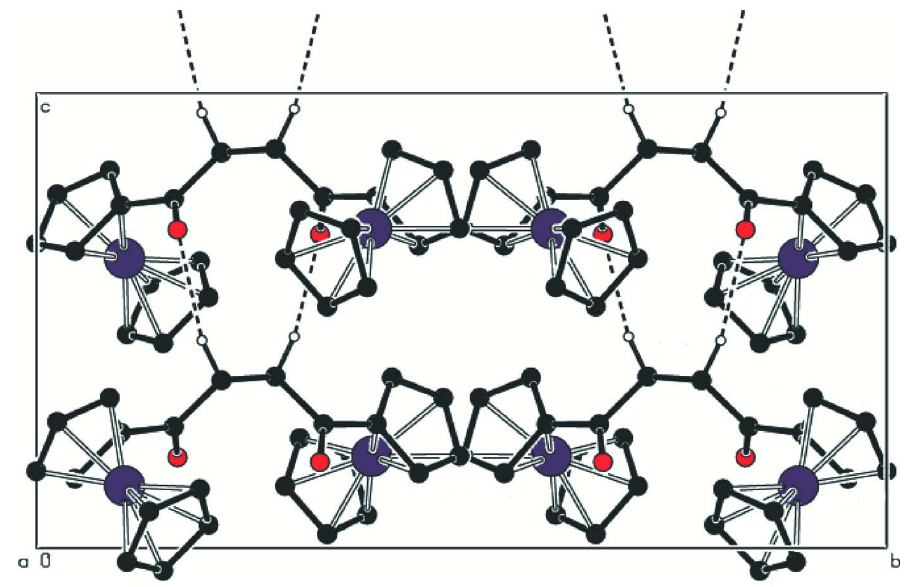
Figure 2 The packing diagram and the intermolecular C—H···O hydrogen bonding interactions of (I), viewed down the a axis. For clarity, H atoms not involved in hydrogen bonding have been